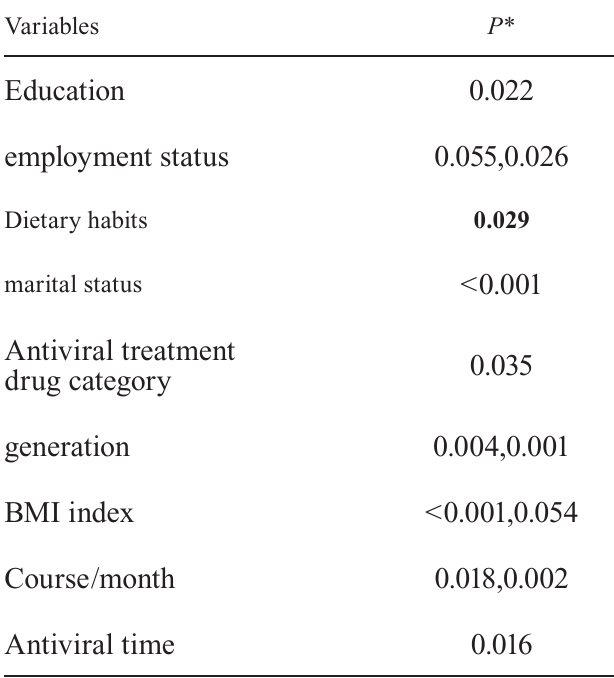
TABLE III - Univariate analysis of potential risk factor for metabolic abnormalities